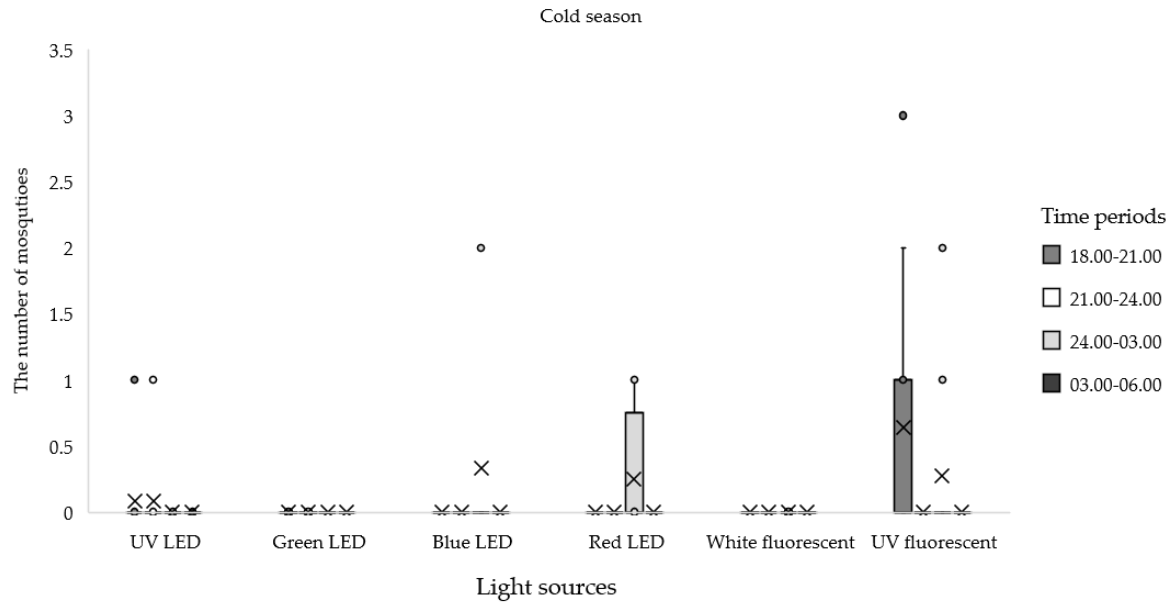
Insects 2021 , 12 , x FOR PEER REVIEW Figure 3. Mean numbers of Anopheles mosquitoes caught at different times of night by using different light traps during the wet season, May to October 2020.